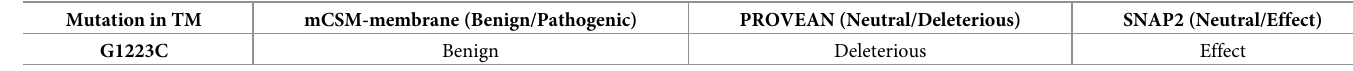
Table 3. Impact prediction of G1223C novel